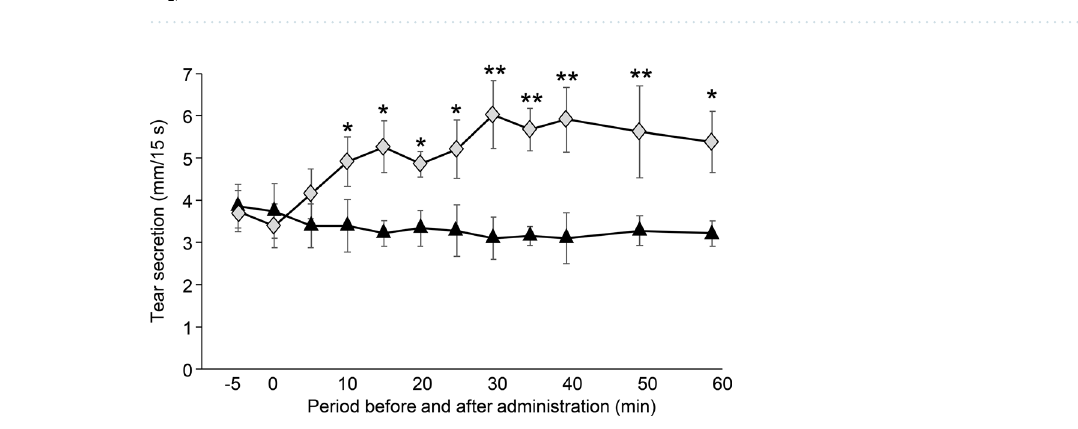
Figure 3. Changes in the subjective ocular symptoms of eye fatigue ( a ), dry eye sensation ( b ), and foreign body sensation ( c ) over time. All results are expressed as the mean ± standard error. Significant differences from the control group are indicated by * p < 0.05 . Black triangle: control, grey diamond: SUPER H2 (molecular hydrogen; H